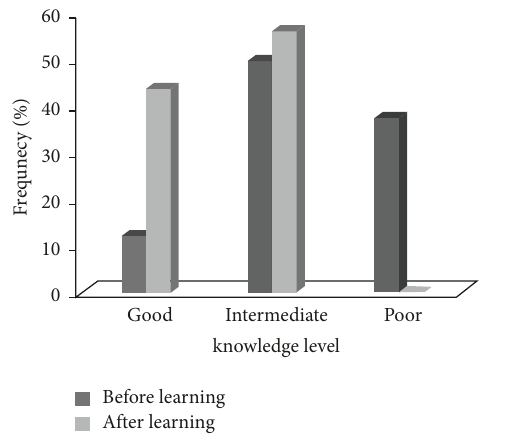
Figure 1: The total mean score of the midwives’ PPH knowledge following electronic continuing medical education compared with before that.